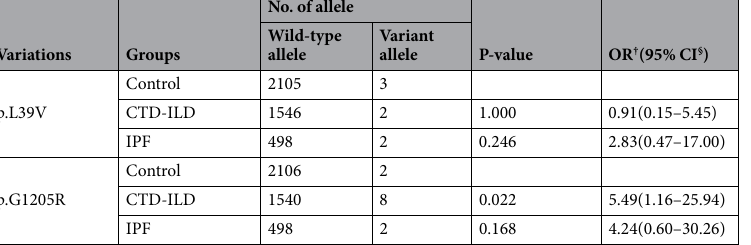
Table 6. Comparisons on the variants p.L39V and p.G1205R in ABCA3 between the different subgroups of ILD patients and healthy controls # . † odds ratio; § 95% confidence interval; # Bonferroni correction was used to adjust the significance level to